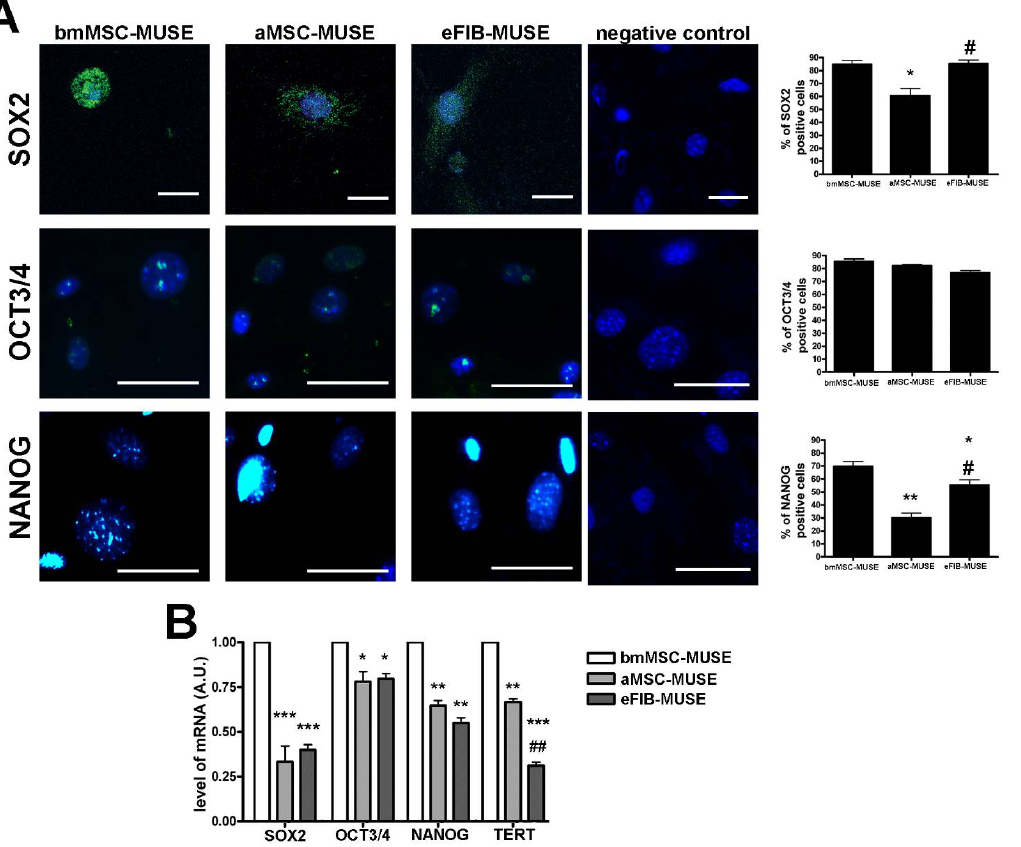
Figure 4. MUSE cells expressed stem cell markers. ( A ) The pictures are representative images of immunocytochemistry for stemness markers: SOX2, OCT3/4, and NANOG, performed on bmMSC-MUSE, aMSC-MUSE and eFIB-MUSE. We performed ICC only with secondary antibodies, as reaction negative control. The nuclei were counterstained with DAPI (blue). The histograms show the percentage of SOX2, OCT3/4, and NANOG-positive cells. The data are expressed with standard deviation ( n = 5). In the last column is reported the immunostaining performed only with secondary antibody (negative control). The bar indicates 50 µ m. ( B ) mRNA expression levels of stem cell genes. The histograms show the quantitative RT-PCR analysis of a group of genes involved in stemness: SOX2, OCT3/4, NANOG and TERT. The mRNA levels were normalized to GAPDH mRNA expression, which was selected as an internal control. Histograms show expression levels in the different MUSE cell and non-MUSE cell populations. Data are expressed as fold changes with standard error ( n = 5). For each gene, the expression level of bmMSC-MUSE is set as the baseline (the arbitrary value is 1). All experimental data are represented as mean ± standard deviation (SD) of five independent replicates ( n = 5). We compared the three MUSE cell populations. The statistical differences among bmMSC-MUSE (first column) and the other MUSE cell population are indicated with * (* p < 0.05, ** p < 0.01, *** p < 0.001). The statistical differences among aMSC-MUSE (second column) and the other MUSE cell populations are indicated with # (# p < 0.05, ## p <